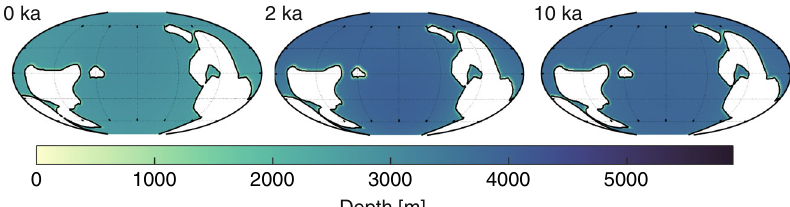
Fig. 4 The ocean bathymetry during the Marinoan deglaciation. From left to right are the bathymetry for the 0 kyr, 2 kyr, and 10 kyr time slices, with times measured from onset of the Marinoan deglaciation 34